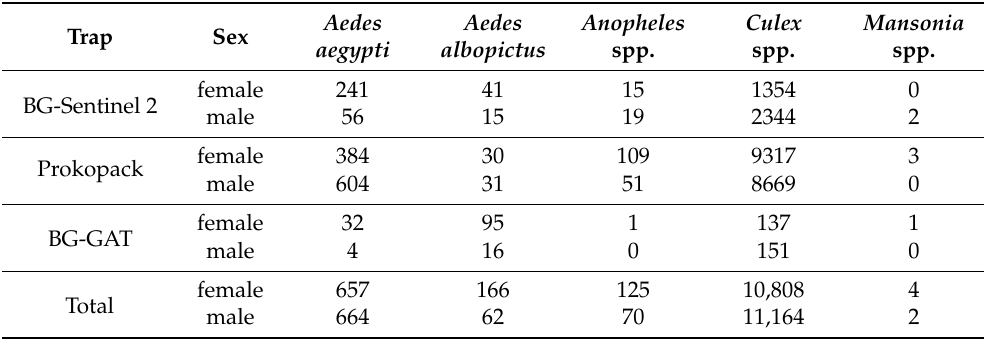
Table 1. Overview of the number of collected mosquitoes per species or genus across all collection methods and